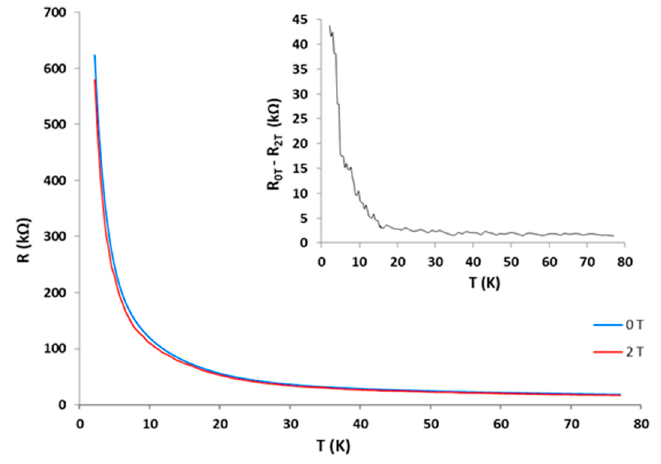
Figure 17. Resistance–temperature curves for sensors at a magnetic field B = 0 T and 2 T. The inset shows the difference of the resistance measured at B = 0 T and 2 T [40].